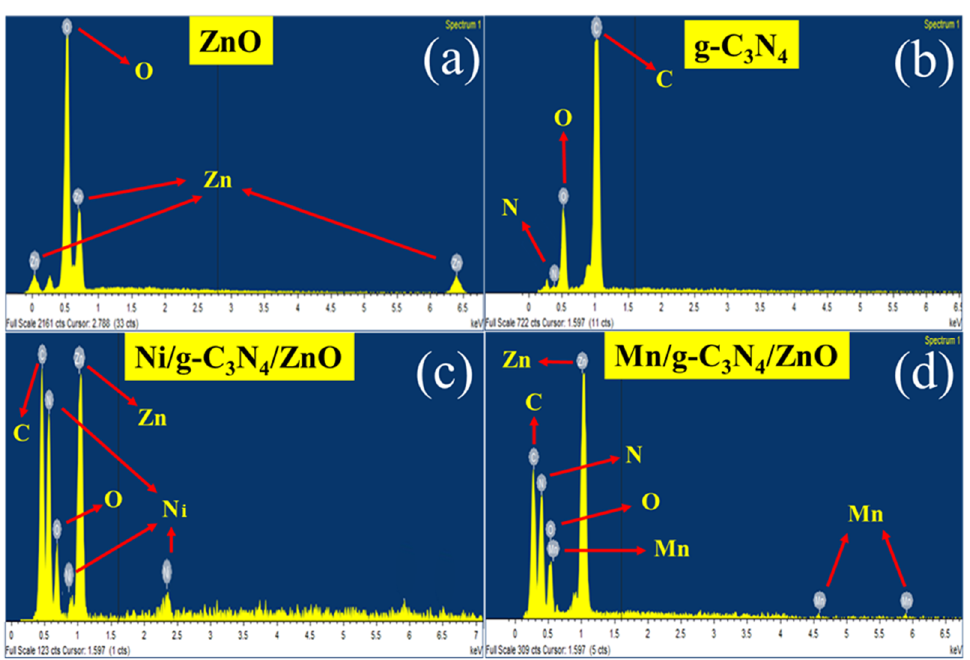
Figure 6. EDX analysis of ZnO ( a ), g-C 3 N 4 ( b ), g-C 3 N 4 /ZnO ( c ), Ni/g-C 3 N 4 /ZnO ( c ), and Mn/g-C 3 N 4 /ZnO ( d ).